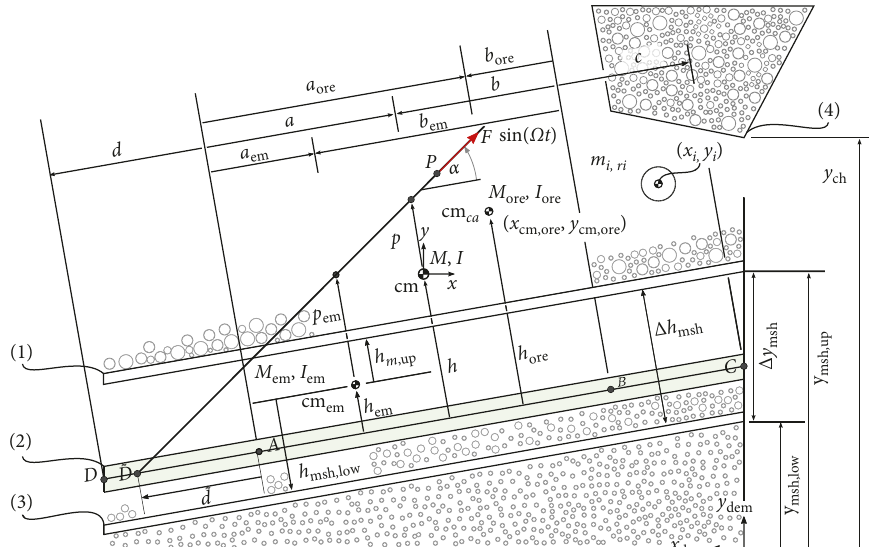
Figure 2: Geometric comparison of dynamic modeling and DEM, showing the change in the center of mass due to the load, with (1) upper screen deck, (2) rigid-body model, (3) lower screen deck, and (4) feed